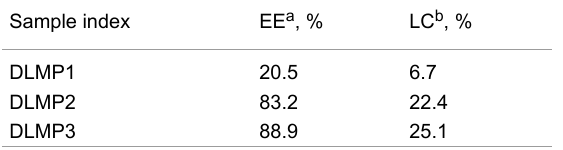
Table 2: Loading capacity comparisons for different